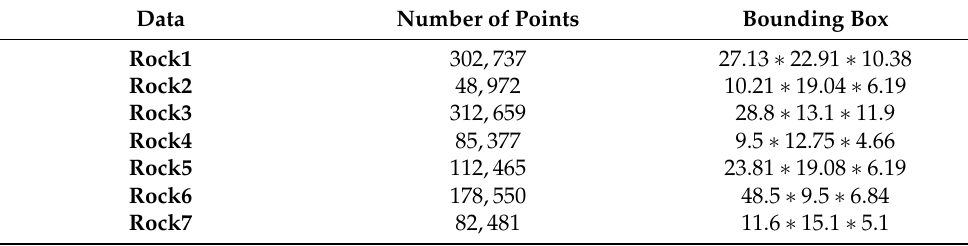
Table 1. Basic infomation of all datasets.